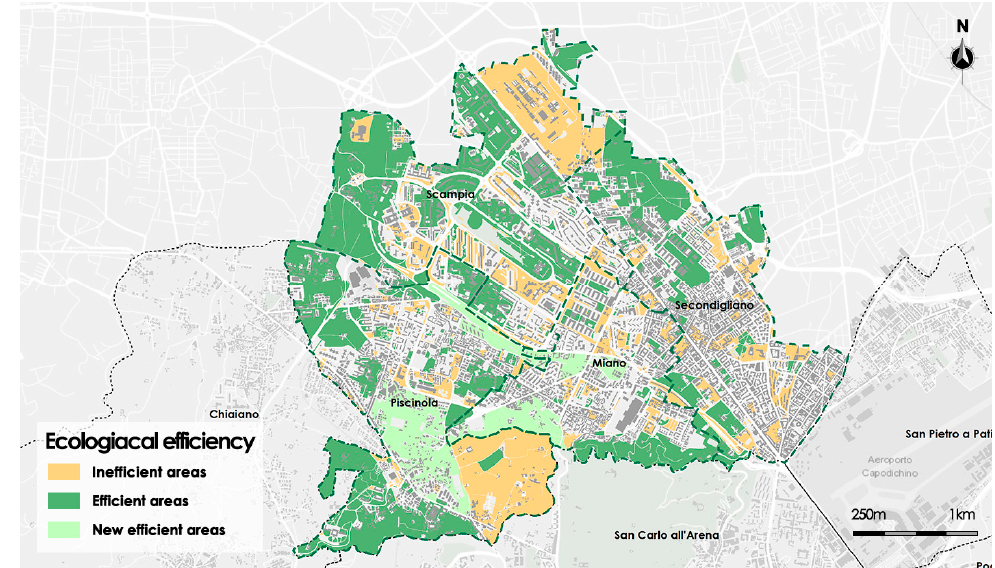
Figure 10. Distribution of ecologically efficient areas after the second intervention strategy.